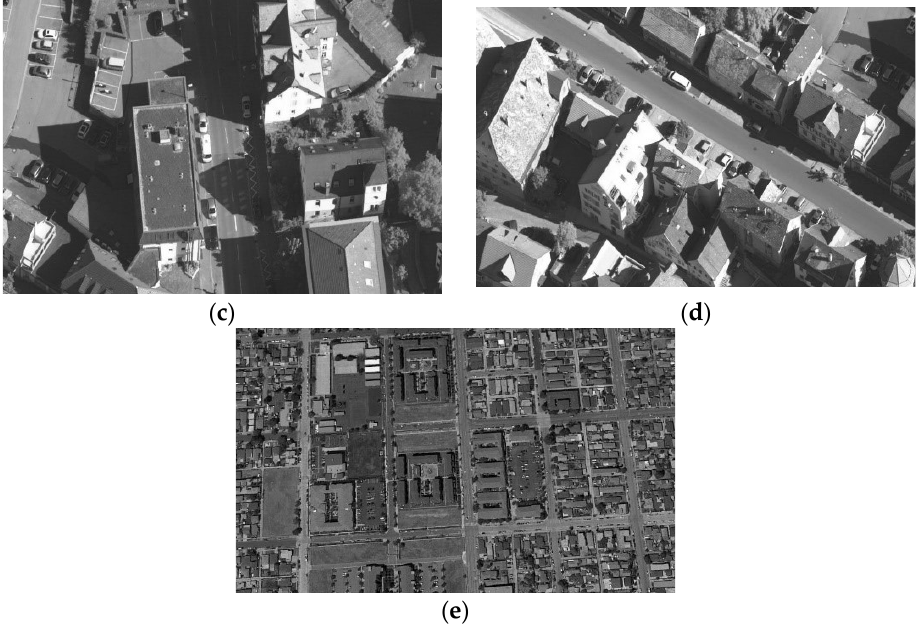
Figure 6. Images used in the experiments. ( a ) Image a; ( b ) Image b; ( c ) Image c; ( d ) Image d; ( e ) Image e.